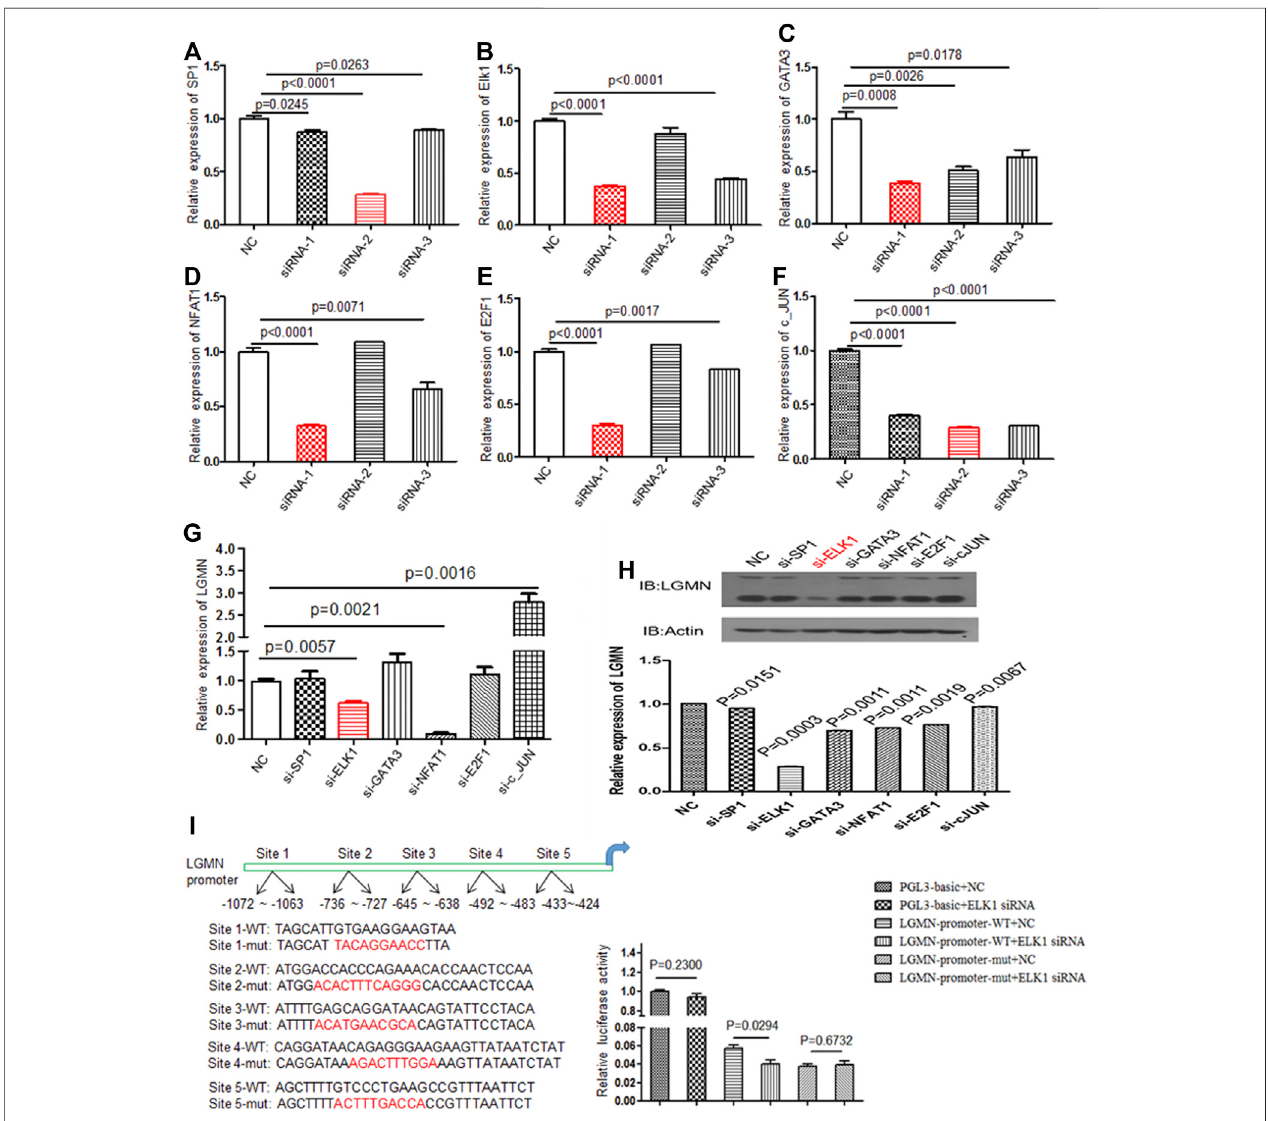
FIGURE 1 | Knockdown of ELK1 reduced LGMN expression in pancreatic cancer cells. (A – F) RT-PCR analysis of SP1, ELK1, GATA3, NFAT1, E2F1 and c-JUN levels after transfection of respective siRNAs in PANC-1 cells. Three types of siRNA were used. (G) RT-PCR analysis of LGMN mRNA expression after transfection of effectivesiRNAsinPANC-1cells,themRNAlevelwasnormalized toGAPDH. p (cid:1) 0.0057betweenELK1-KDandcontrolgroup, p (cid:1) 0.0021betweenNFAT1and control group. (H) Western blot analysis of LGMN levels after transfection of effective siRNAs in PANC-1 cells. (I) Luciferase assay of LGMN transcriptional activity after transfection of ELK1 siRNAs or control in PANC-1 cells. p (cid:1) 0.029 between LGMN-promoter-WT+siELK1 and control group.